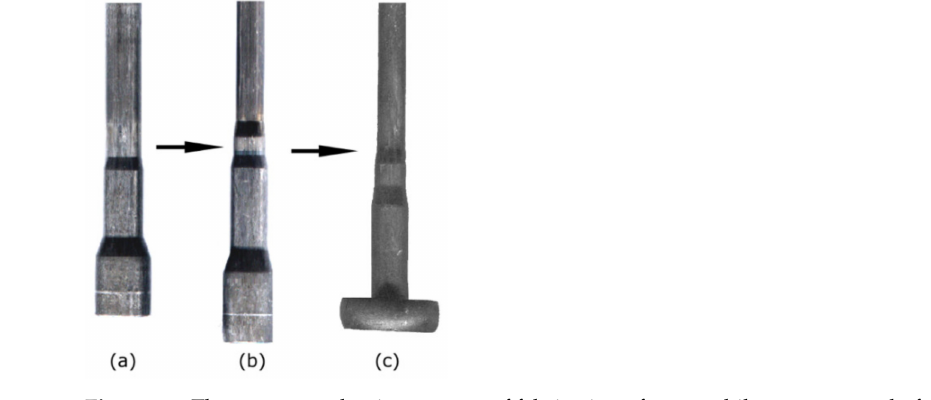
Figure 12. Three-step production process of fabrication of automobile component shaft via automatic sequential machine: pre-processing ( a ); direct extrusion ( b ); stamping ( c